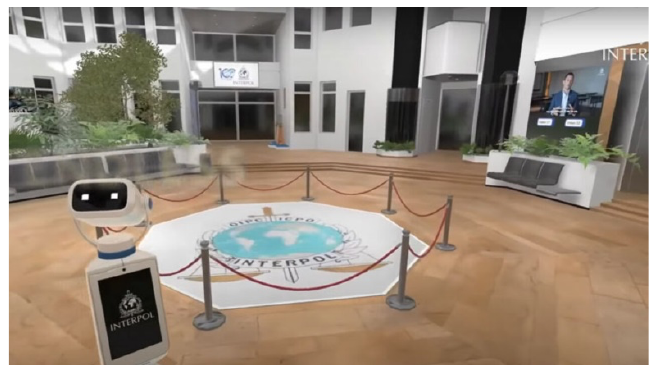
Figure 36: INTERPOL’s office in the metaverse World Economic Forum in the metaverse: